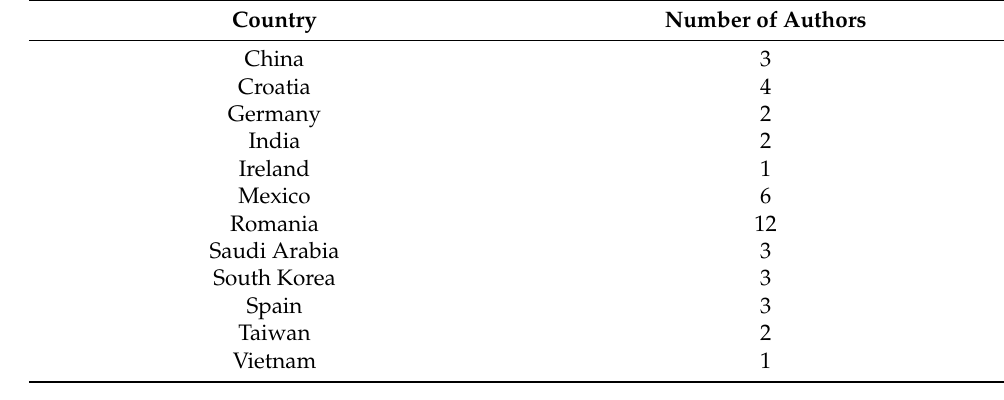
Table 1. Geographic distribution of authors by